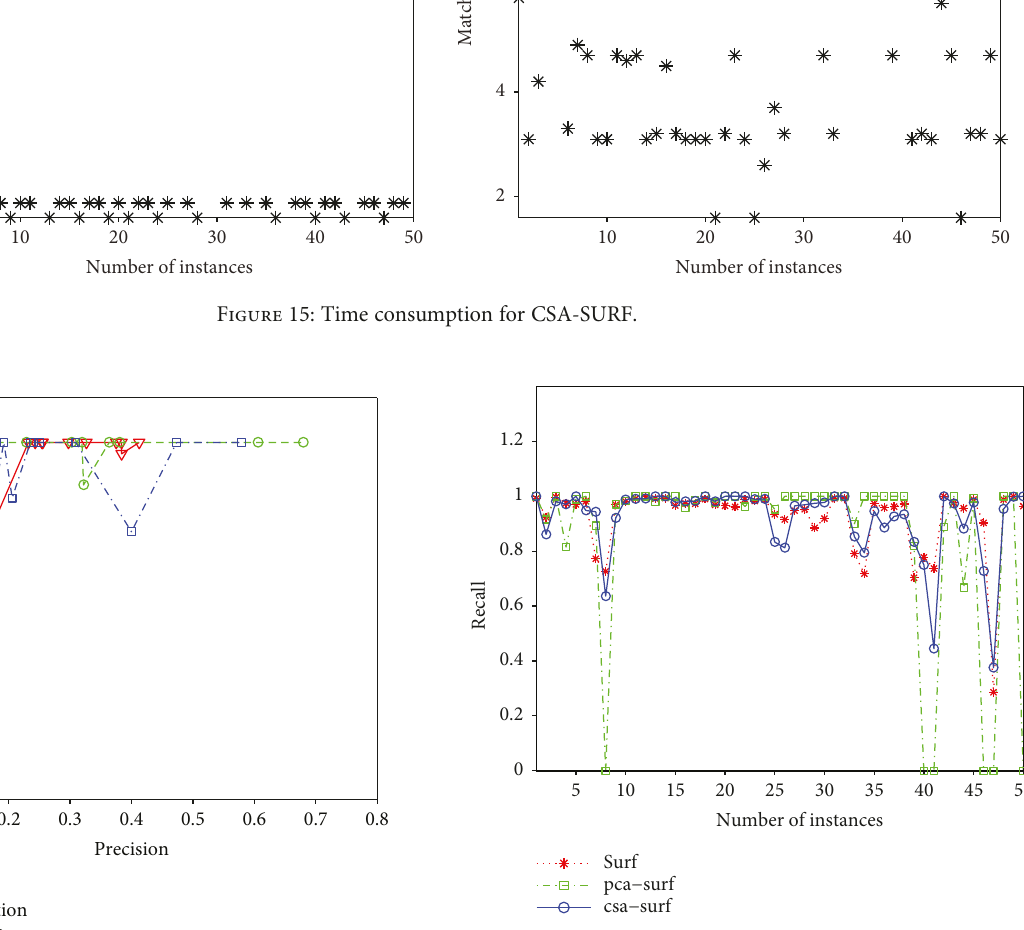
Figure 17: Recall of di ff erent